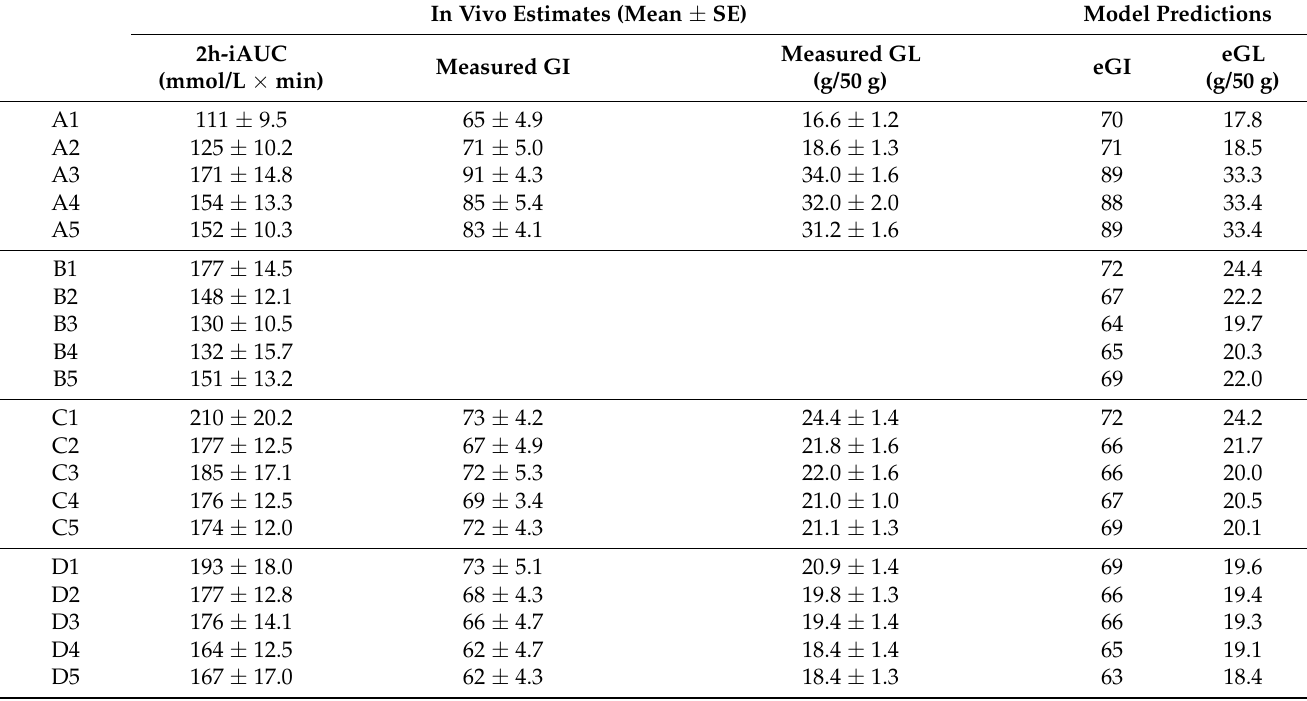
Table 2. In vivo estimates (mean ± SE) of the 2h-iAUC, GI and GL and model predictions of eGI and eGL of 20 samples, including 5 precooked, dried cereal flours (A1–A5) and 15 infant cereal prototypes